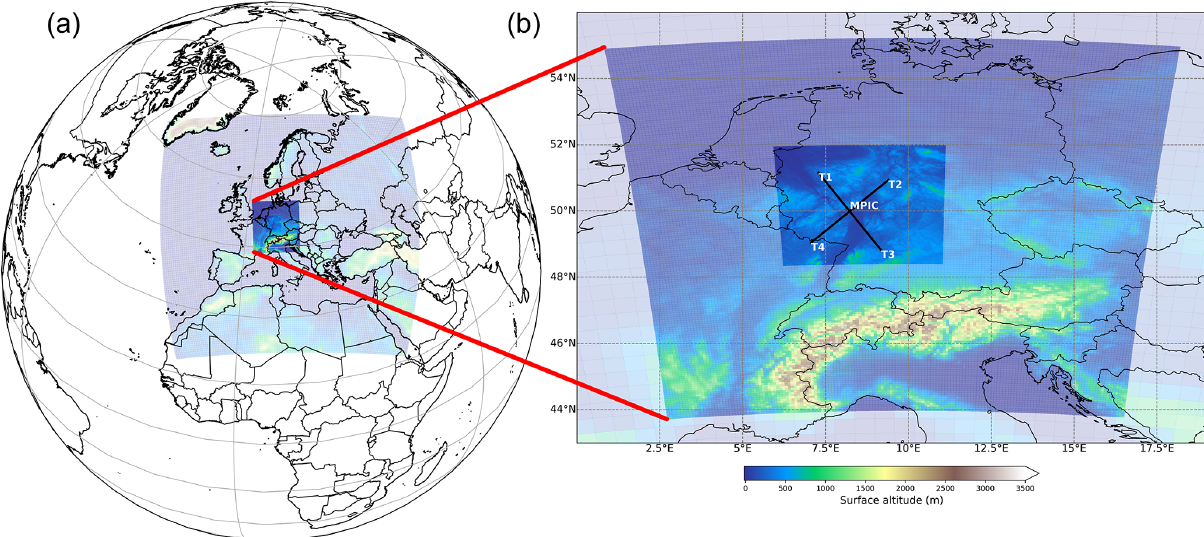
Figure 1. MECO(3) domains in panel (a) colour-coded according to the surface altitude. A close-up of the map in the right panel shows the CM07 and CM02 domains. The location of MPIC (Max Planck Institute for Chemistry) is shown as the red dot in panel (b) with the arrows pointing in the viewing direction of the four